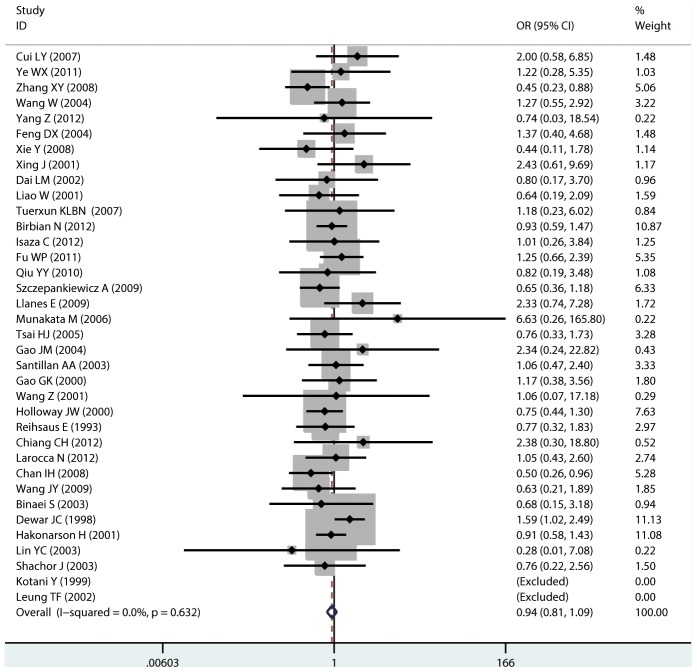
Forest plots of the association between the Gln27Glu (rs1042714) polymorphism and risk of asthma in recessive model comparison.